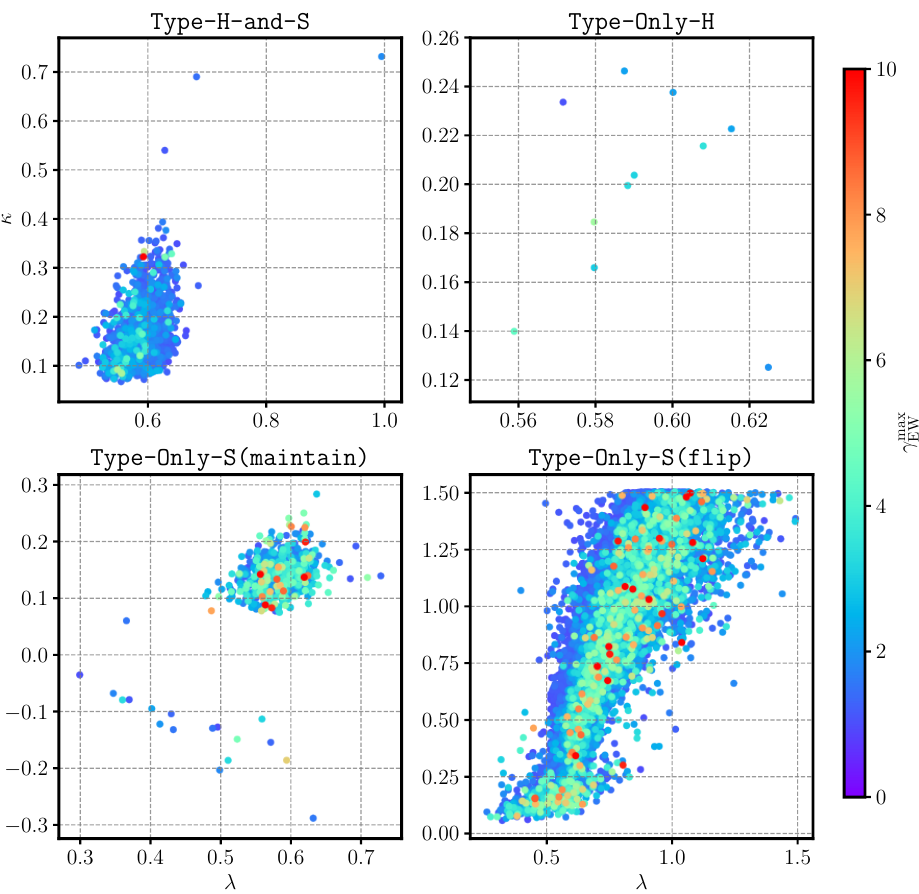
Figure 5 . The quartics ( (cid:21); (cid:20) ) for samples for which the strongest FOPT ends in the SM vacuum. The points are colored by the (cid:13) EW of the strongest